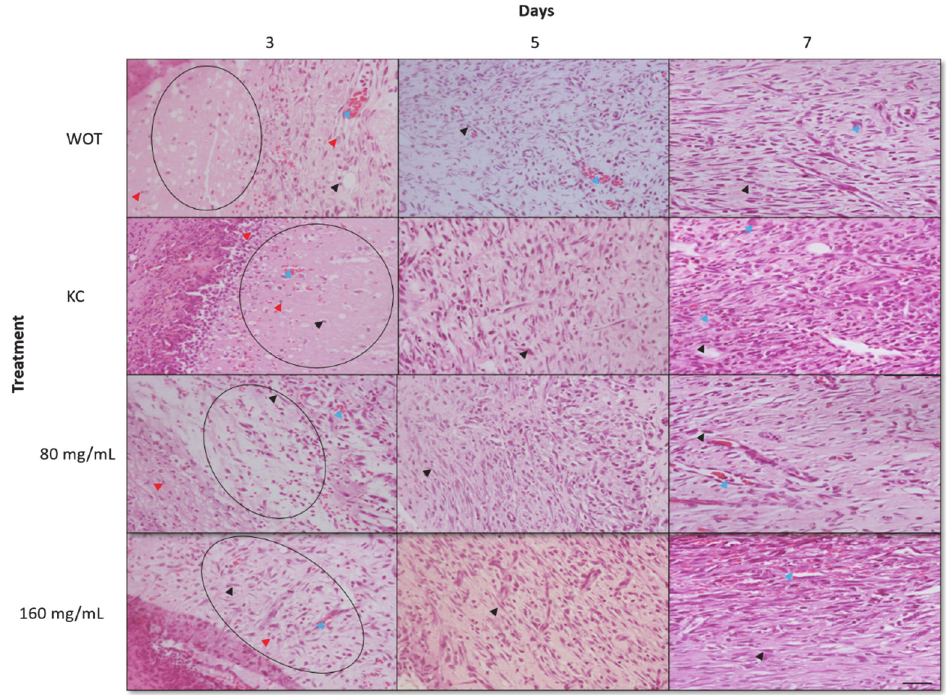
Figure 4. Hematoxylin and eosin (H&E) staining of wounds. Representative microphotographs at 3, 5, and 7 days post ‐ wounding in WOT, KC, and 80 and 160 mg/mL of PB . Edema tissue (open circles), inflammatory cells (red arrow), fibroblasts (black arrow), blood vessels (blue arrow). Bar = 20 µ m.